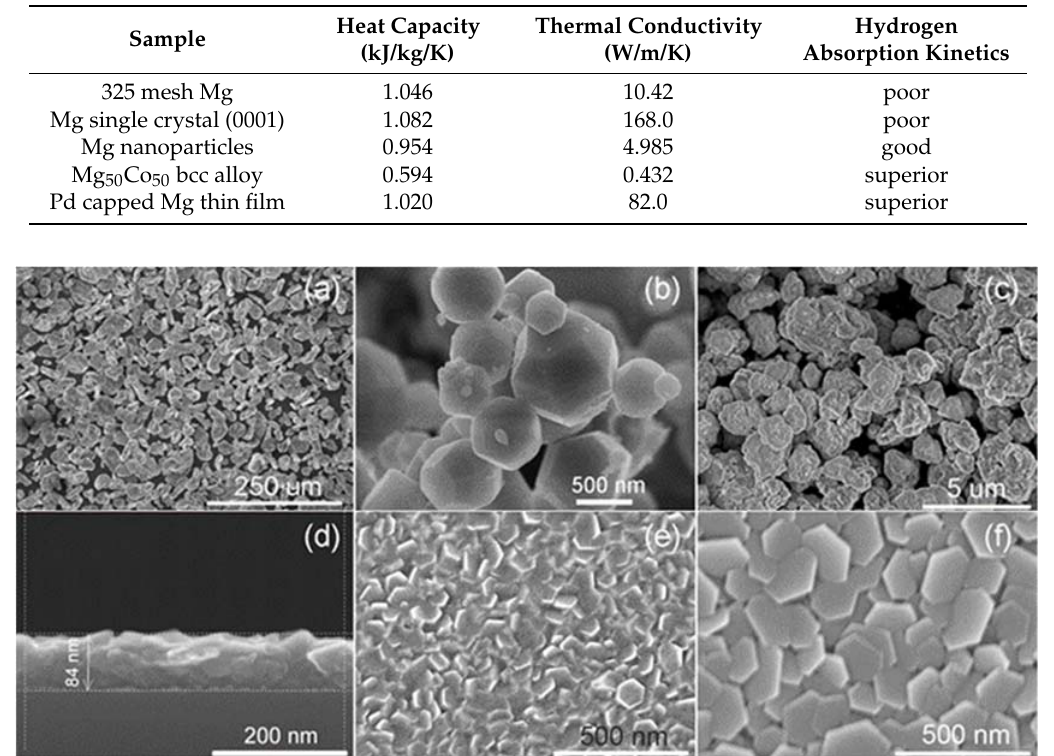
Figure 8. SEM images of ( a ) 325 mesh Mg, ( b ) Mg nanoparticle sample, ( c ) milled Mg 50 Co 50 BCC alloy, ( d ) cross-section observation of Mg thin film without Pd layer, ( e ) top view of Mg thin film without Pd layer and ( f ) top view of Pd capped Mg thin film. Reproduced with the permission from [78], Copyright Elsevier, 2014.